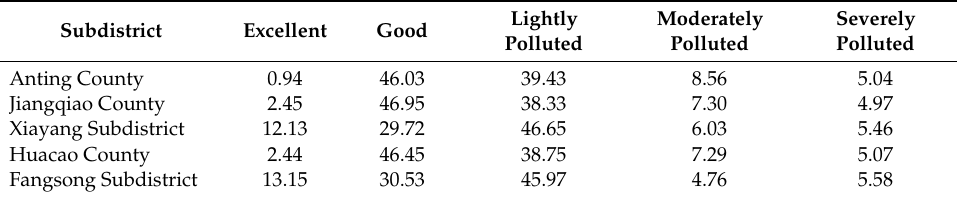
Figure 13. Relationship between the percentage of residents’ time away from residence and the corresponding percentage of exposure levels. Table 6. Details of the exposure risk percentage of residents in the top five